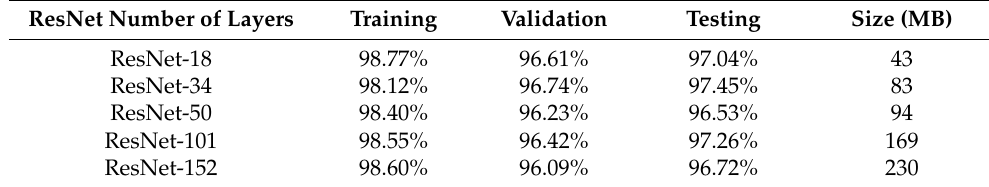
Table 3. Evaluating the first classification stage accuracy and model size to determine the layer size for ResNet.